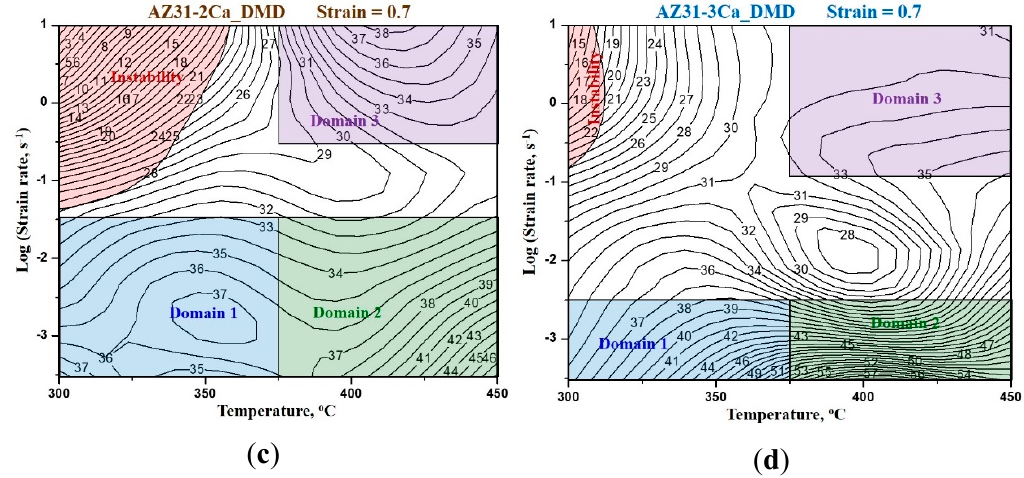
Figure 10. Processing maps obtained at a strain of 0.7 on DMD processed ( a ) AZ31, ( b ) AZ31-1Ca, ( c ) AZ31-2Ca, and ( d ) AZ31-3Ca alloys. The numbers indicated on the contours represent efficiency of power dissipation expressed as percent.